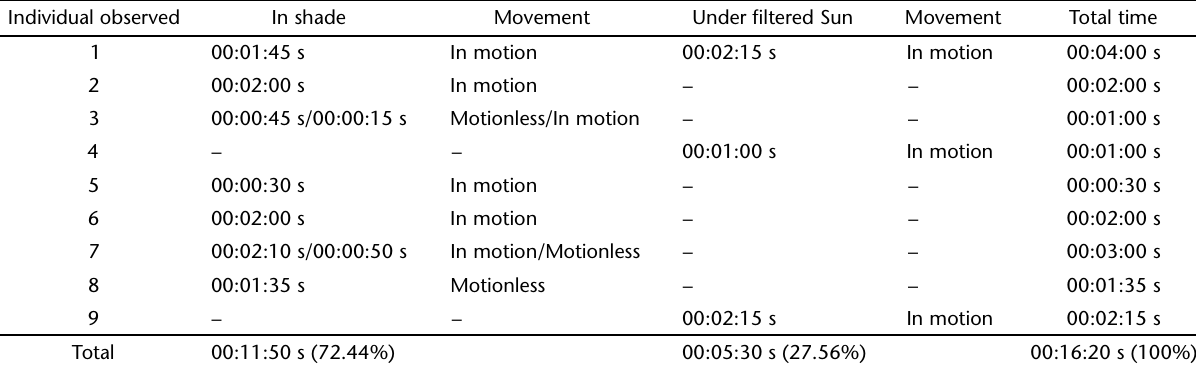
Table II. Length of exposure to light conditions and movement for Coleodactylus natalensis (n = 9). Individual observed